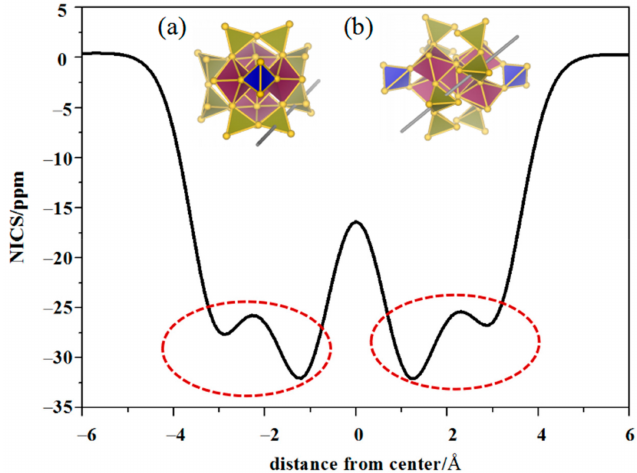
Figure 6. NICScc-scan curve of the Au 46 16 + core, which is the scan along the centers of the neighboring Au 4 superatoms in the range of –6.0–6.0 Å. The red dotted ovals in the figure signal the presence of Au 4 superatoms. The structures labeled in ( a ) and ( b ) indicate two views of the